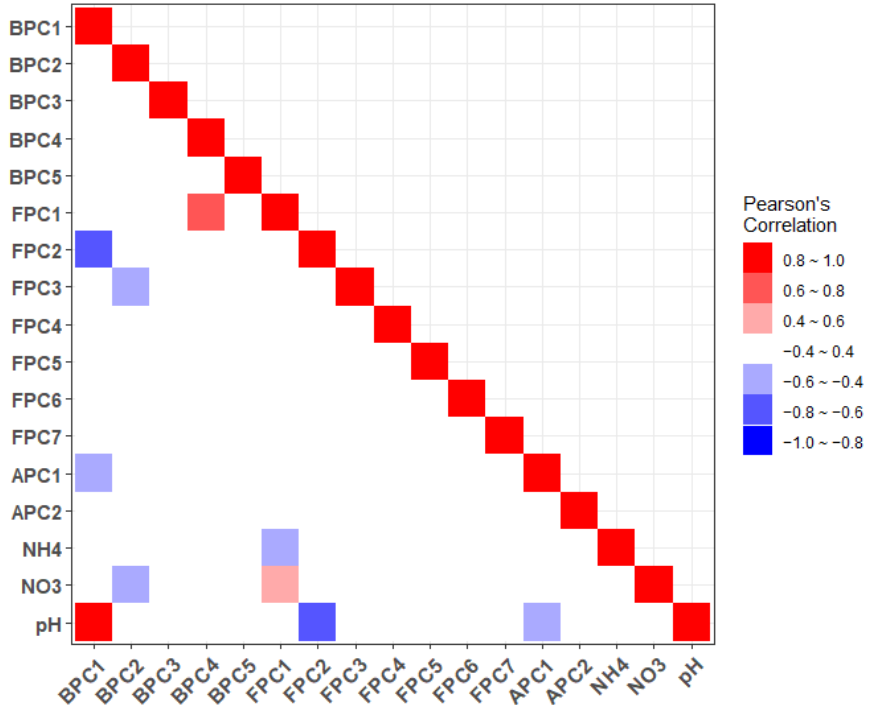
Figure 8. The heatmap depicting the matrix of Pearson’s correlation coefficients among the principal components (PCs) of the bioindicators and the selected soil properties: soil ammonium (NH4), nitrate (NO3), and pH. The red and blue hues indicate positive and negative associations, respectively. The higher saturation of these colors indicates greater absolute values of Pearson’s correlation as shown in the legend on the right. BPC#, bacterial PC; FPC#, fungal PC; APC#, archaeal PC.